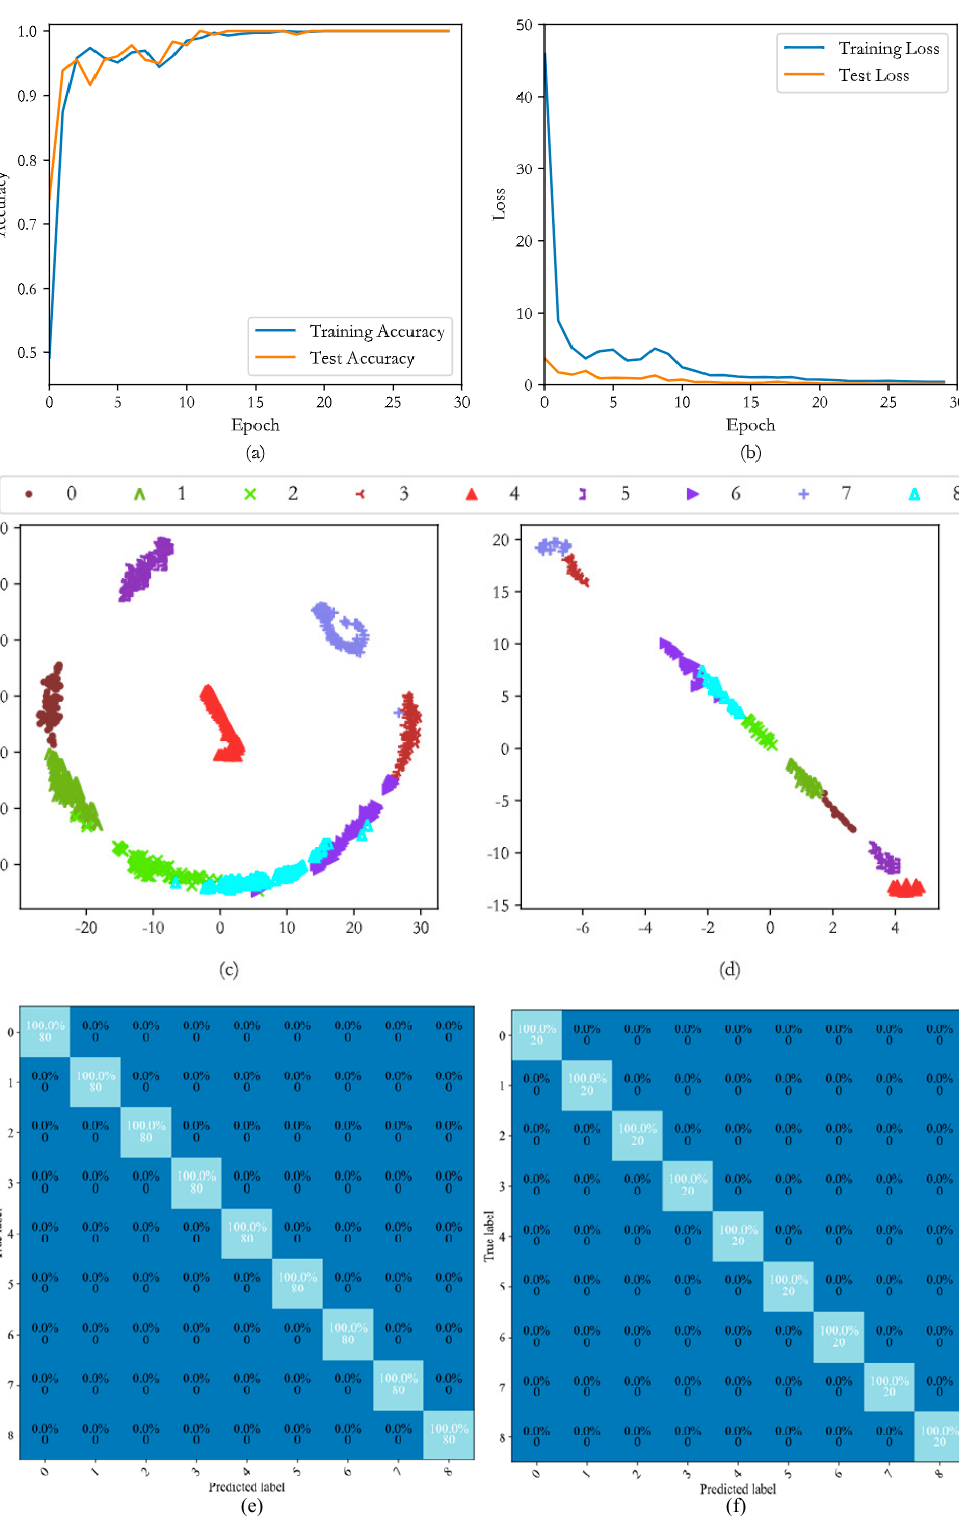
Figure 8. Training and test results. ( a , b ) are the changes of the accuracy and loss of the training and testing datasets with epoch, ( c , d ) are the visualization results of the training and testing results by t-SNE, ( e , f ) are the confusion matrix of the training and test results.